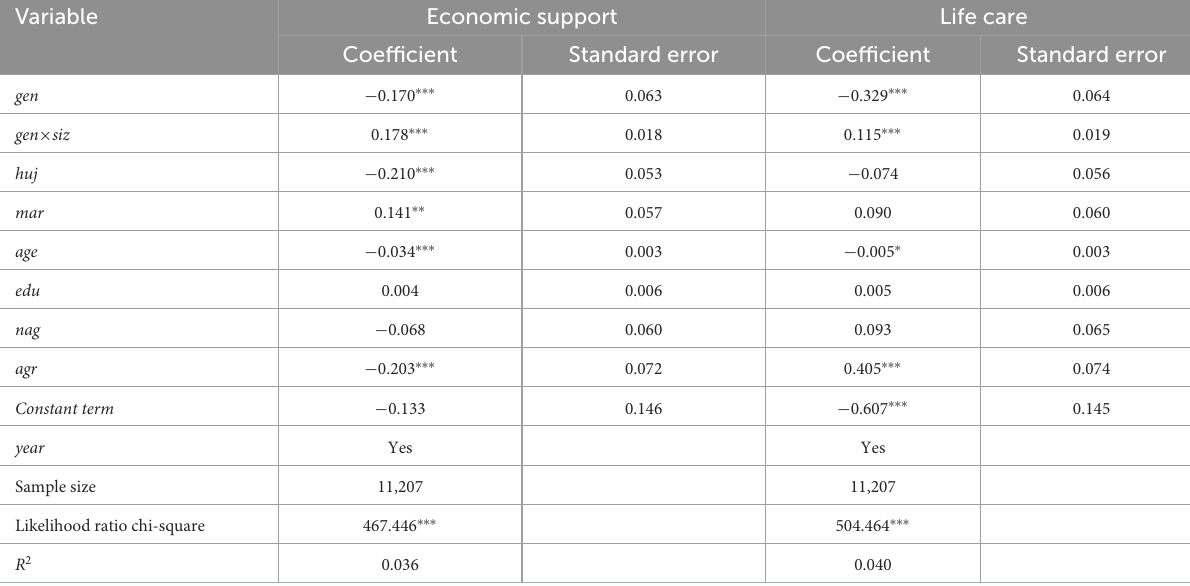
TABLE 7 Estimated results of the influence of family size on children’s contribution to their parents’ care.